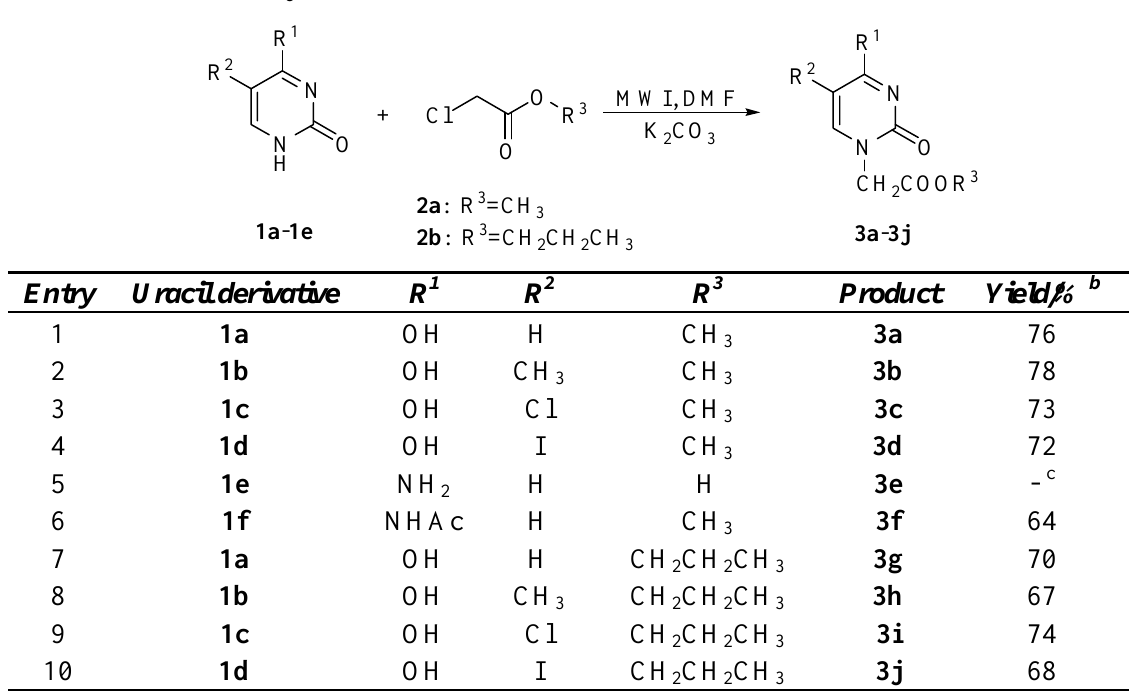
Table 2 . Alkylation of Various Uracil Derivatives in DMF under MWI a